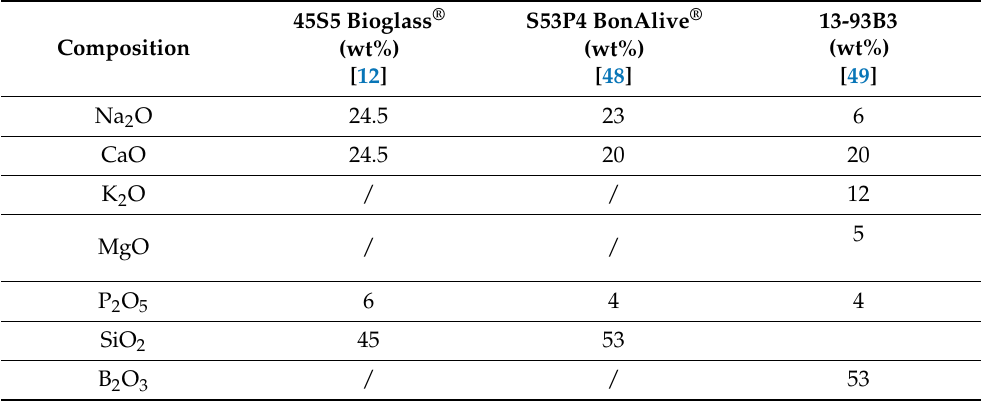
Table 1. Chemical composition of 45S5 bioactive glass (Bioglass ® ), S53P4 bioactive glass (BonAlive ® ), and the 13-93B3 borate-based glass used for clinical trials in dentistry, reconstructive surgery (bone regeneration), and the treatment of infections